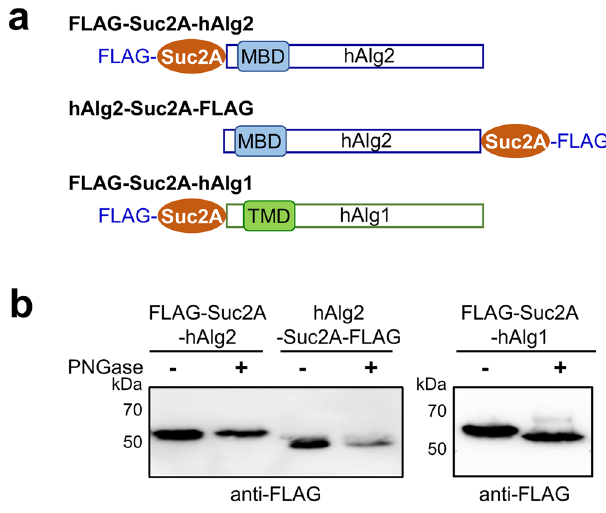
Fig. 2 Mapping the orientation of hAlg2 N-terminus. a Schematic representation of the FLAG-Suc2A-hAlg2, hAlg2-Suc2A-FLAG and FLAG- Suc2A-hAlg1 constructs. The hAlg2 was fused to a yeast invertase fragment (Suc2A) and tagged with FLAG epitope. The Suc2A contains three NX(S/T) sites, which acts as a reporter for N-glycosylation. b Western blotting of FLAG-Suc2A-hAlg2, hAlg2-Suc2A-FLAG, and FLAG-Suc2A-hAlg1 expressed in HEK293 cells with or without PNGase F treatment. Table 1 Plasmids used in this